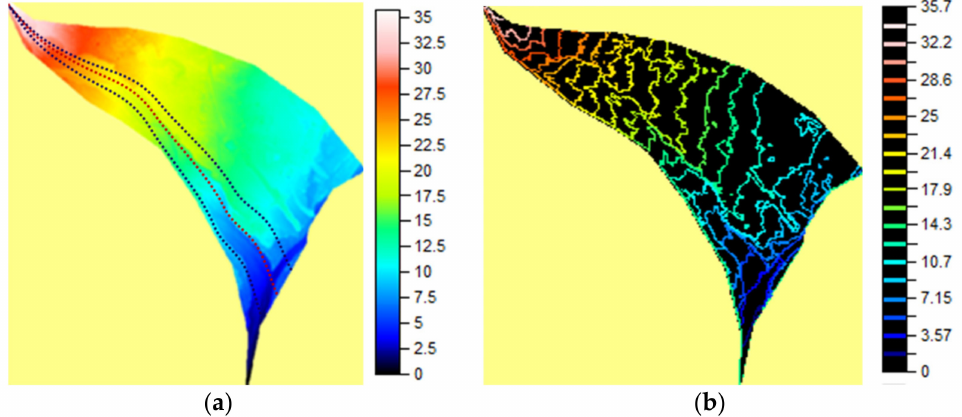
Figure 6. DEM of alluvial fan area No. 7 with a 5 m grid spacing: ( a ) maximum slope line; ( b ) drainage